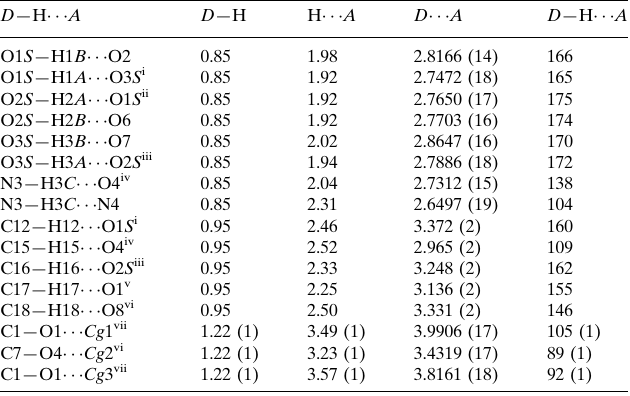
Hydrogen-bond geometry (A˚ , (cid:3)